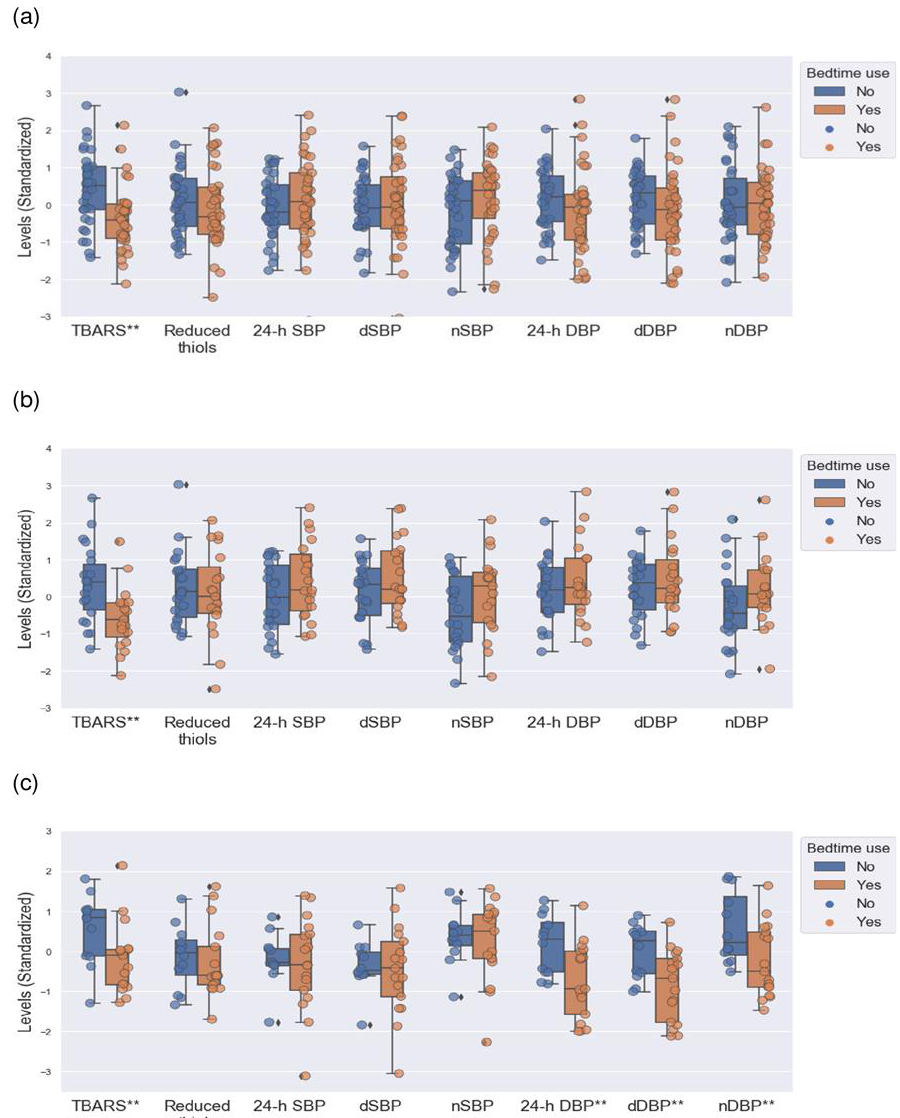
Figure 1. Comparison of redox markers levels and 24-h ABPM indices between patients with morning and bedtime use of RAAS blockers. ( a ) Hypertensive patients. ( b ) Dipper hypertensive patients. ( c ) Non-dipper hypertensive patients. Box-and-whisker diagram. The horizontal line of the box represents the median, and the upper and lower box edges represent the 3rd and 1st quartiles (Q), respectively. The edges of the upper and lower whiskers represent the Q3 + 1.5 × interquartile range and Q1 − 1.5 × interquartile range, respectively. Data represented by diamonds are outliers. The point cloud represents the distribution of the sample values. The non-standardized results expressed as median and interquartile range are shown in Tables 2 and 3. TBARS levels, reduced thiol concentrations, and blood pressure indices were measured in nmol/mg Lp, mmol/L, and mmHg, respectively. Terms: 24-h ABPM–Twenty-four-hour ambulatory blood pressure monitoring; RAAS–Renin-angiotensin-aldosterone system; SBP–Systolic blood pressure; 24-hSBP–Average SBP over 24 h; dSBP–Average SBP during the day; nSBP–Average SBP during the night; DBP–Diastolic blood pressure; 24-hDBP–Average diastolic BP over 24 h; dDBP–Average DBP during the day; nDBP–Average DBP during the night; nmol/mg Lp–Nanomol per milligram of serum lipoprotein; mmol/L–Millimolar; mmHg–Millimeter of mercury. ** refers to a p -value of lower than 0.05.